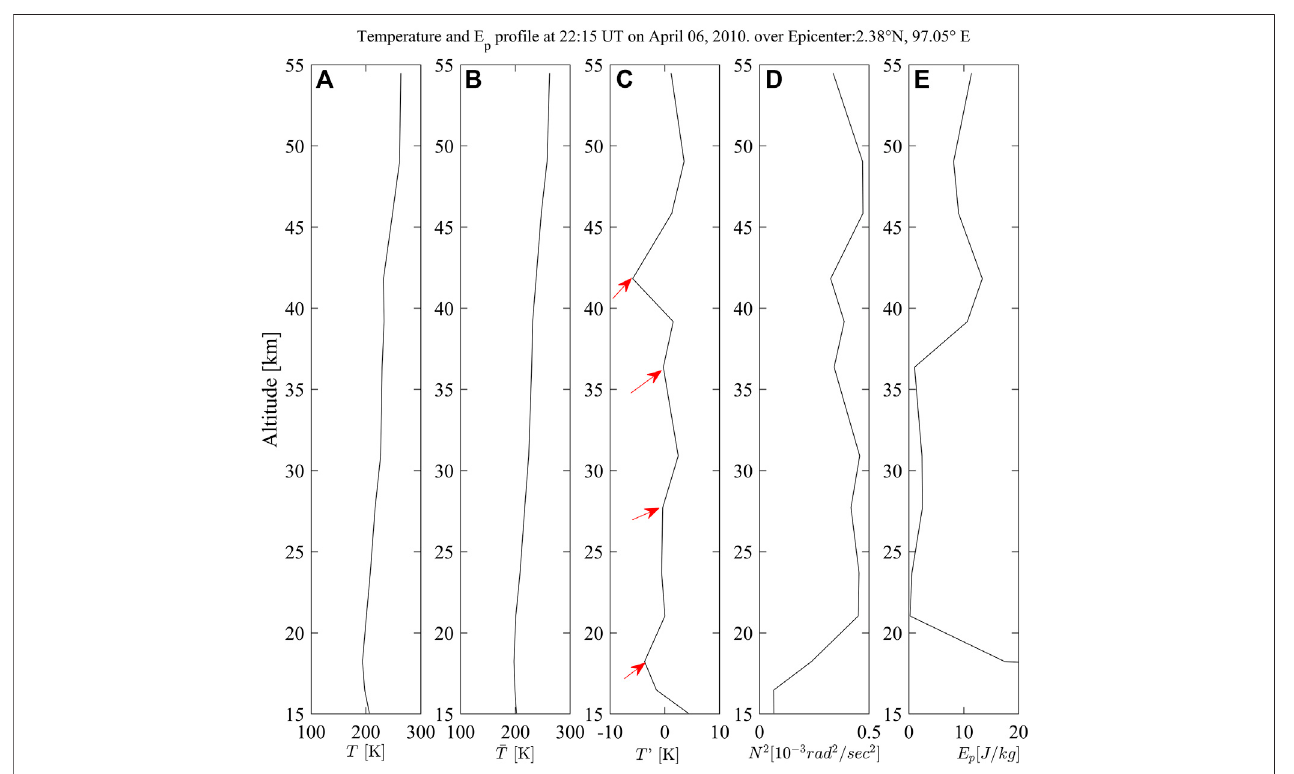
FIGURE11| The simulation ofAcoustic Gravity Wavespropagation over the2010Mw7.8Sumatra epicenter.Fromleft toright: (A) thevertical temperature pro fi le retrieved from ERA-5 dataset; (B) the background temperature pro fi le fi ltered by an every 2 km moving average of Figure 11A ; (C) the temperature deviation between Figures 11A,B ; (D) the squared term N 2 of the Brunt-Väisälä frequency; (E) the potential energies ( E P ) computed over epicenter area.